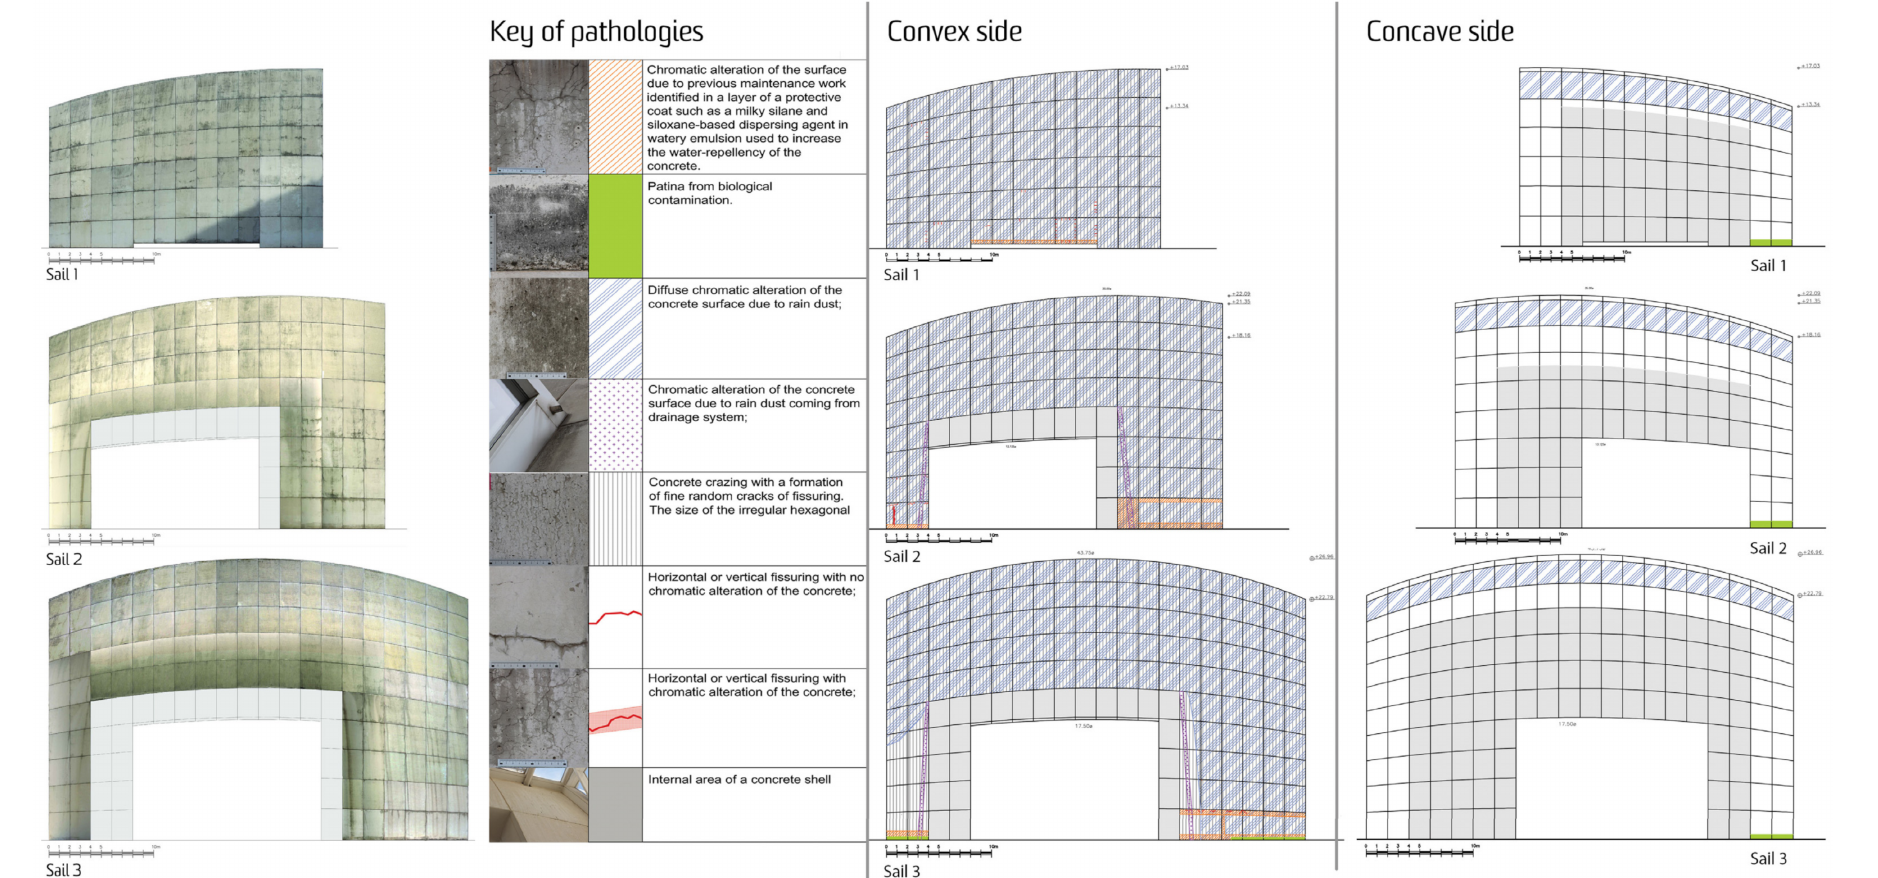
Figure 1. Jubilee Church, Rome (2003). Analysis of the concrete pathologies (Cardellicchio,